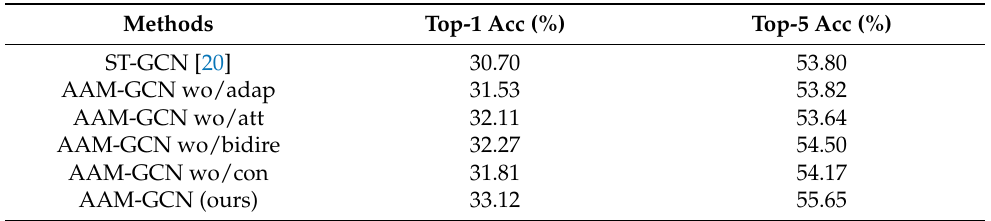
Table 4. Ablation experiments on the Kinetics dataset. “ST-GCN” [20] is compared as a baseline method. For the setting of each method, please refer to Section 5.4.